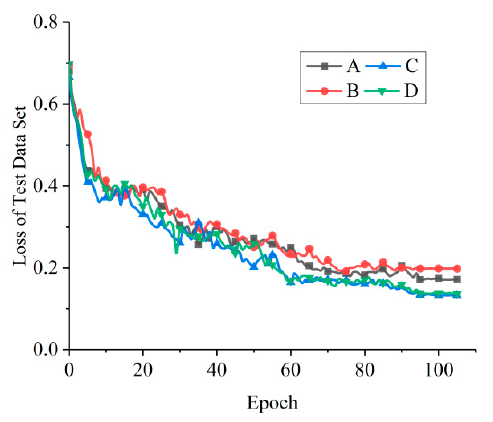
Figure 5. The loss curves of four networks with different convolutional layer structures.